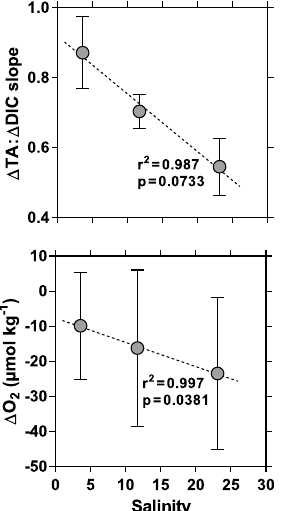
Figure 9. Variation as a function of salinity of the slope of the regression line of the deviation from conservative mixing lines of total alkalinity ( (cid:49) TA, µmolkg − 1 ) and of dissolved inorganic car- bon ( (cid:49) DIC, µmolkg − 1 ) of O 2 ( (cid:49) O 2 , µmolkg − 1 ) in the side chan- nels of the Mekong delta in December 2003, April 2004, and Octo- ber 2004. The dotted line indicates the linear regression. Error bars indicate standard deviation.